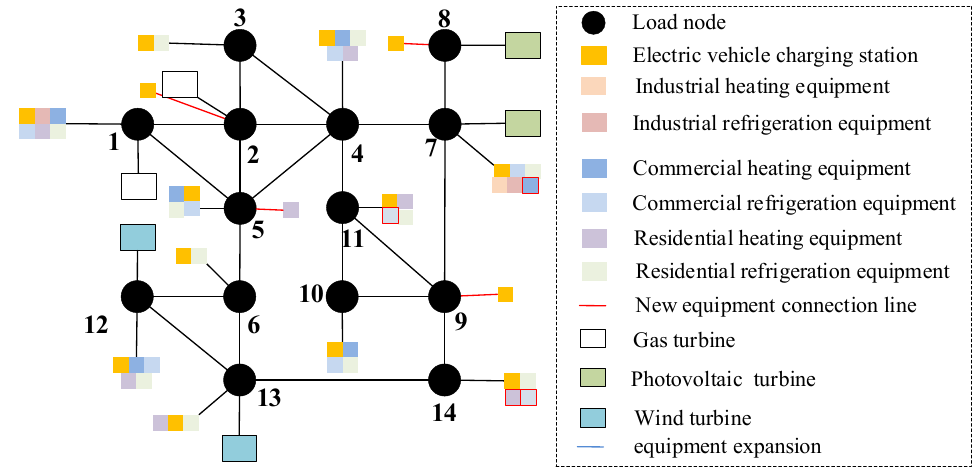
Sensors 2022 , 22 , x FOR PEER REVIEW 23 of 30 Figure 21. Morphological evolution of distribution network in 2025. Figure 21. Morphological evolution of distribution network in 2025.